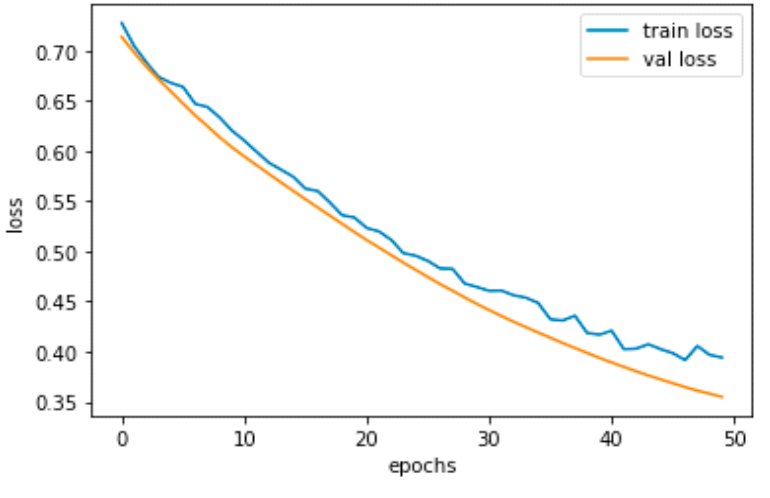
Figure 11. Model training